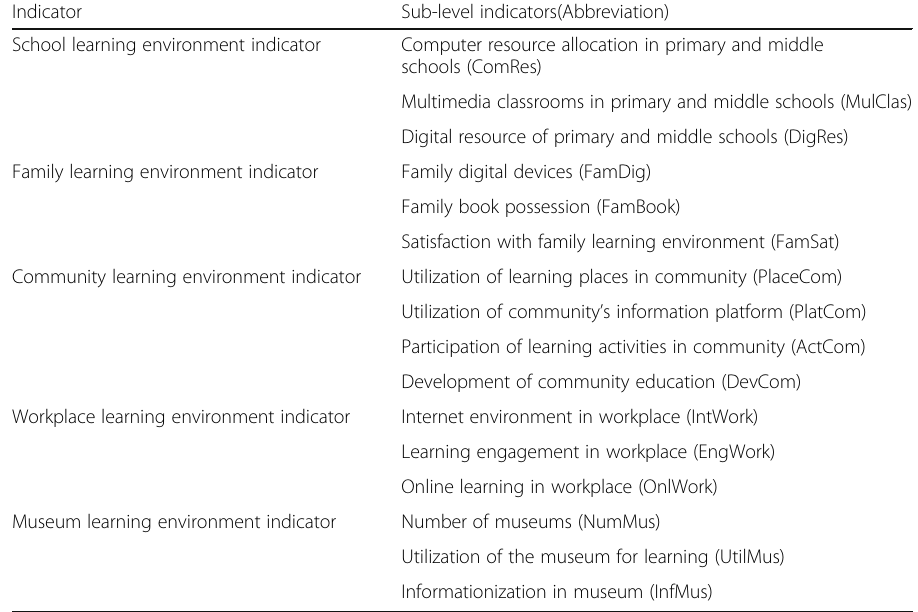
Table 2 Indicators for the five typical learning environments in smart cities